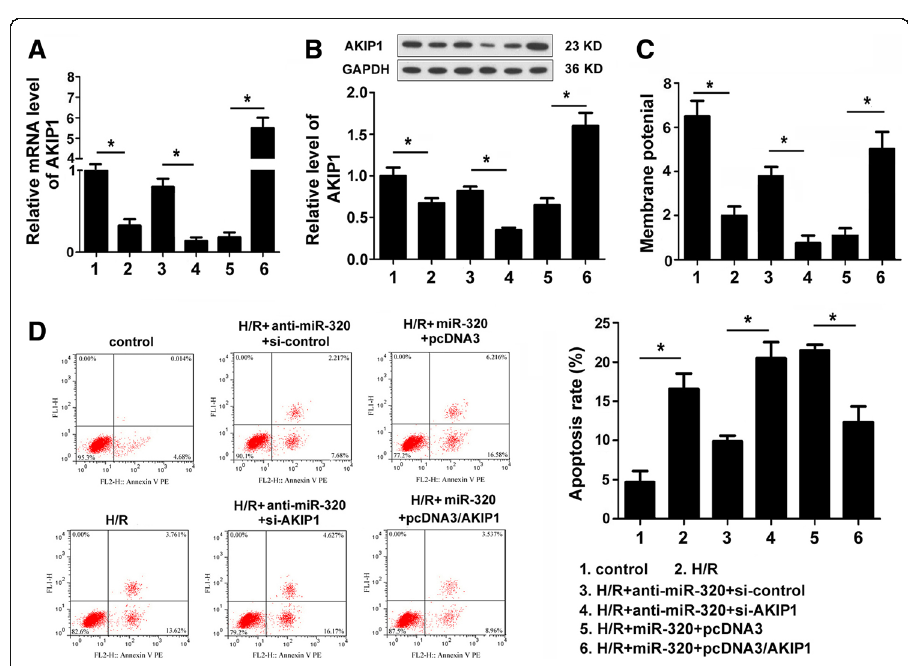
Fig. 5 MiR-320 performed its role in H9c2 cells subjected to H/R by downregulating AKIP1 expression. The expression levels of AKIP1 mRNA and protein in H9c2 cells after the co-transfection of anti-miR-320 and si- AKIP1 or miR-320 and pcDNA3/AKIP1 vector were measured via qRT-PCR ( a ) and Western blot ( b ), respectively. c The effect of AKIP1 expression on the mitochondrial membrane potential was detected.